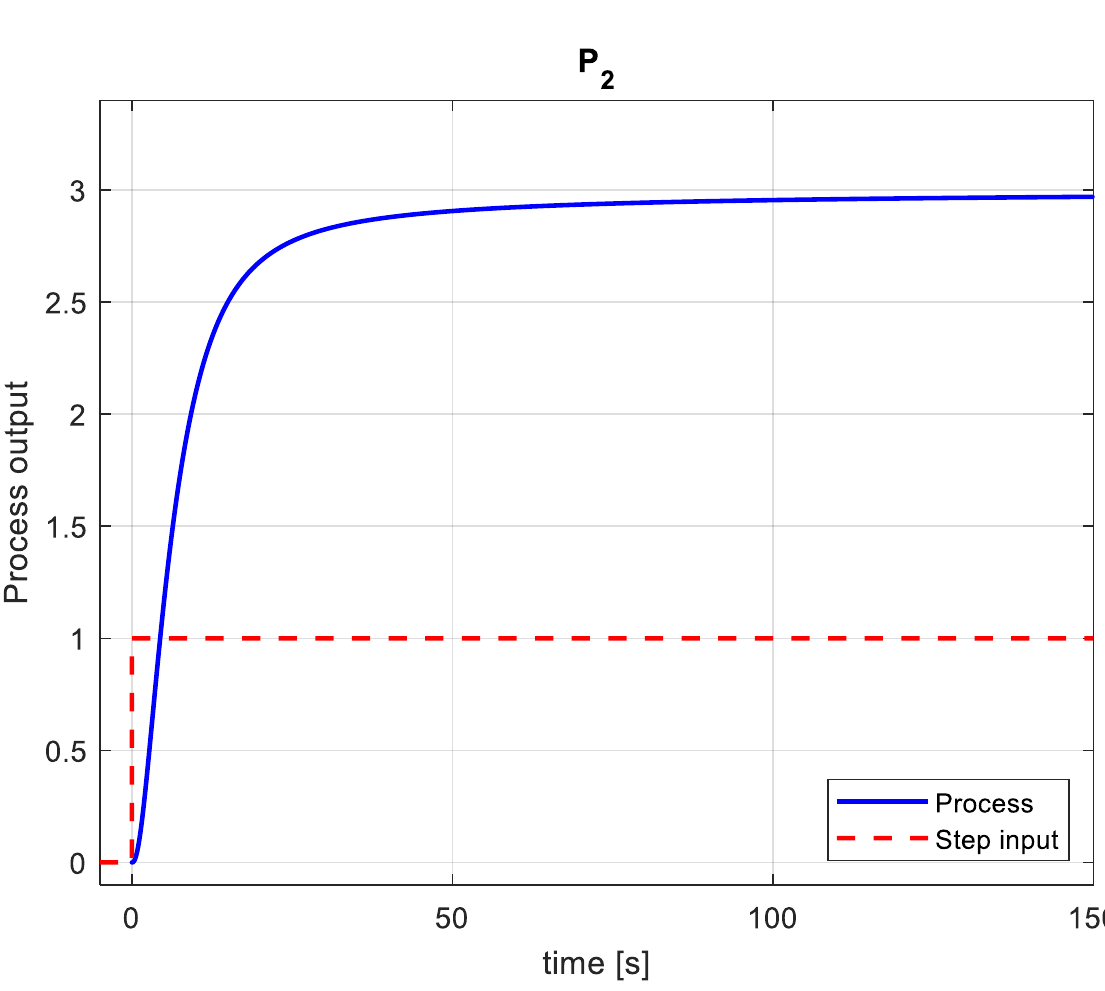
Figure 14. Process reaction curve for process P 2 and step-input signal. Table 16. Process information collected from the reaction curve for fractional-order model identifi- cation of process P 2 .